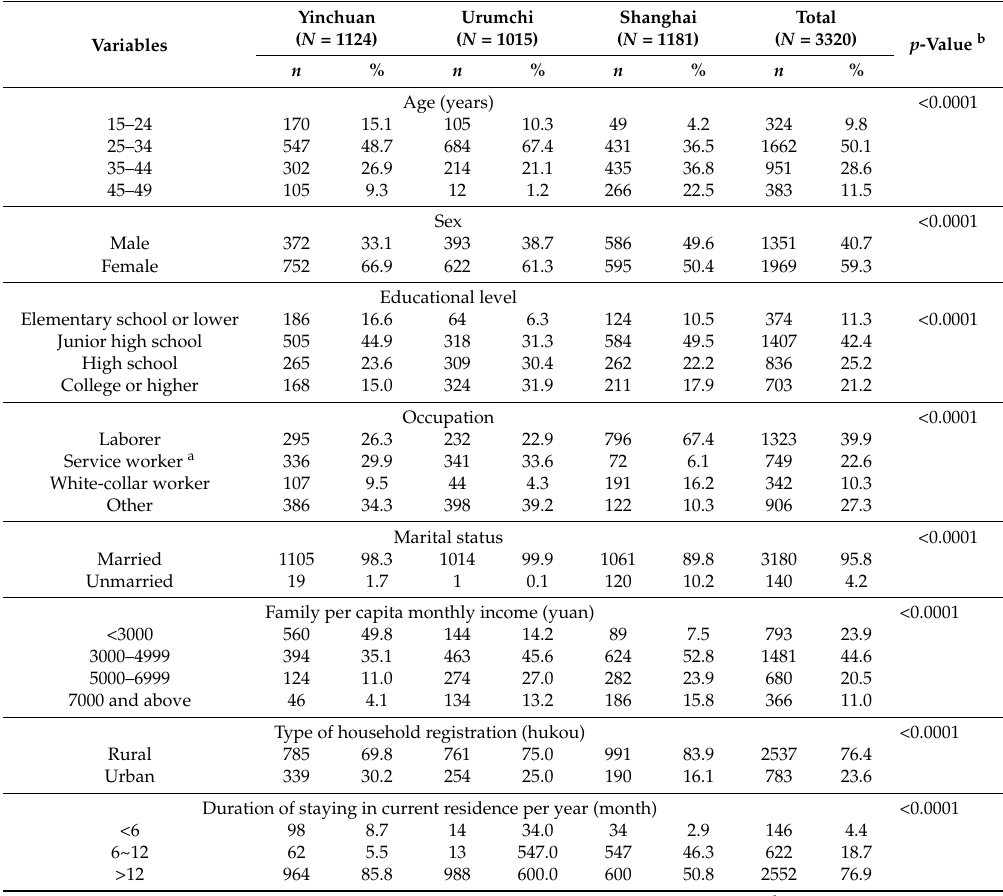
Table 1. Socio-demographic characteristics of the study